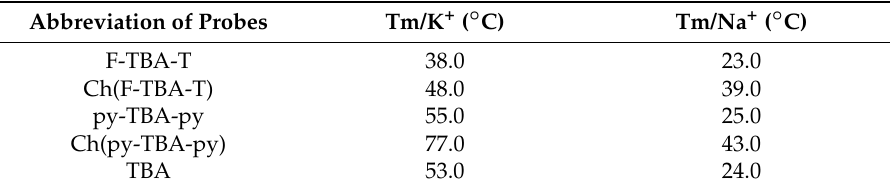
Table 2. Melting temperatures (Tm) for quadruplex-forming oligonucleotide probes determined from dependences of absorbance at 295 nm in the presence K + and Na +